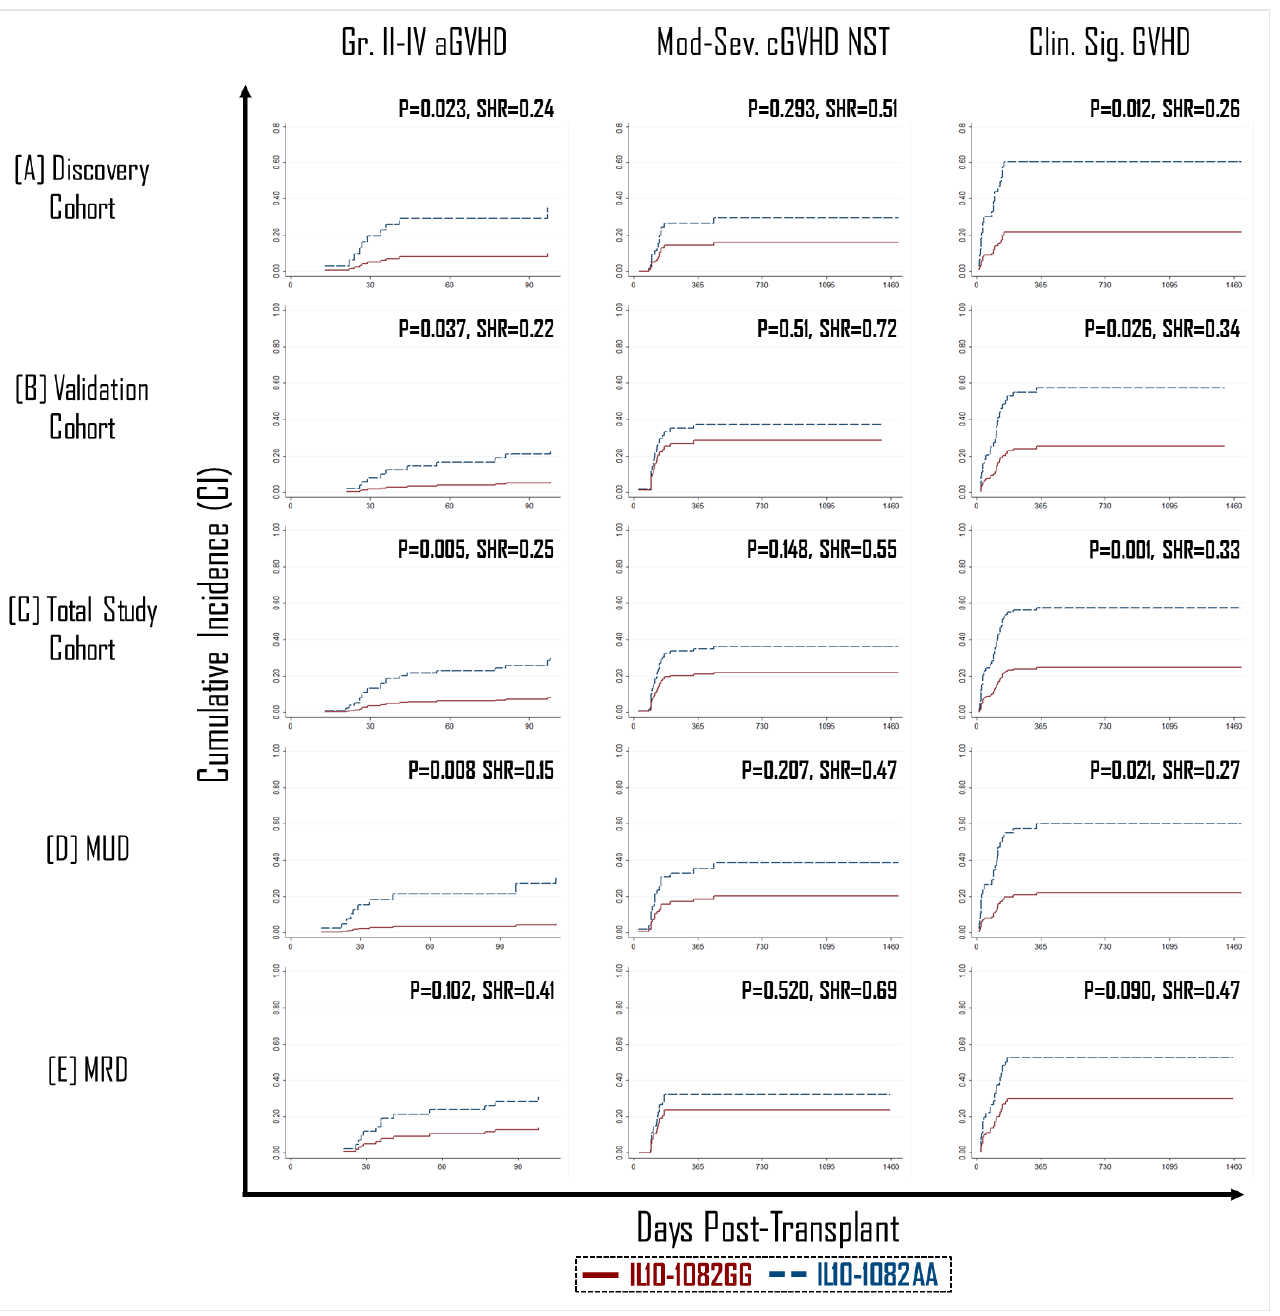
Figure 1. Recipients of IL10-1082GG positive graft had a three-fold lower incidence of grade 2 – 4 acute GVHD (aGVHD) ( left panel ) and clinically significant GVHD ( right panel ) than recipients of an IL10-1082AA positive graft across both the randomly allocated discovery ( A ) and validation ( B ) cohorts, as well as in the total study cohort ( C ). The protective effect of the IL10-1082GG variant was more pronounced in matched unrelated donor (MUD) HCT ( D ), than matched related donor (MRD) HCT ( E ). No impact of IL10-1082 polymorphisms was observed on the incidence of moderate – severe chronic GVHD (cGVHD) ( middle panel ).